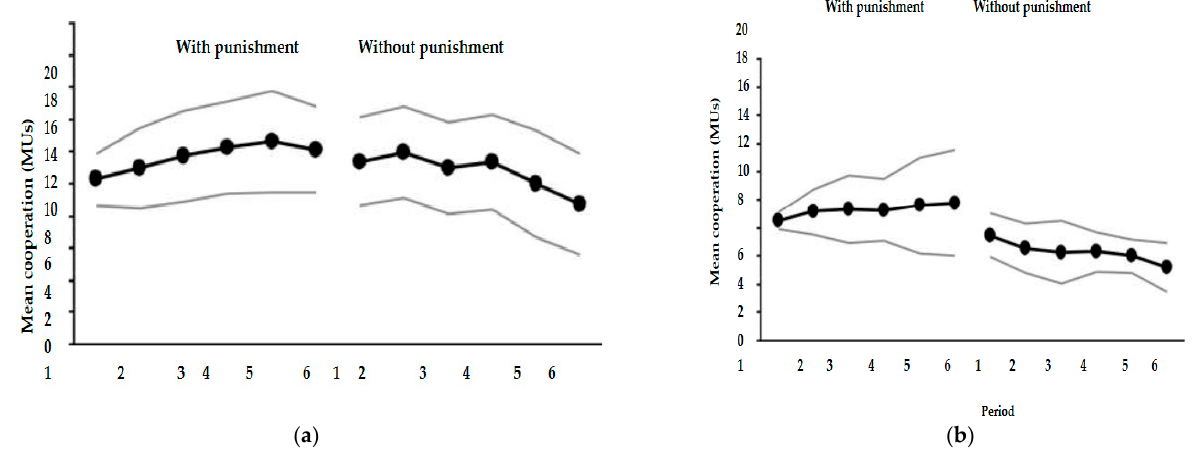
Figure 1. Mean contribution for ‘partners’ ( a ) and ‘strangers’ ( b ) as functions of period in the punishment and the no-punishment phases.